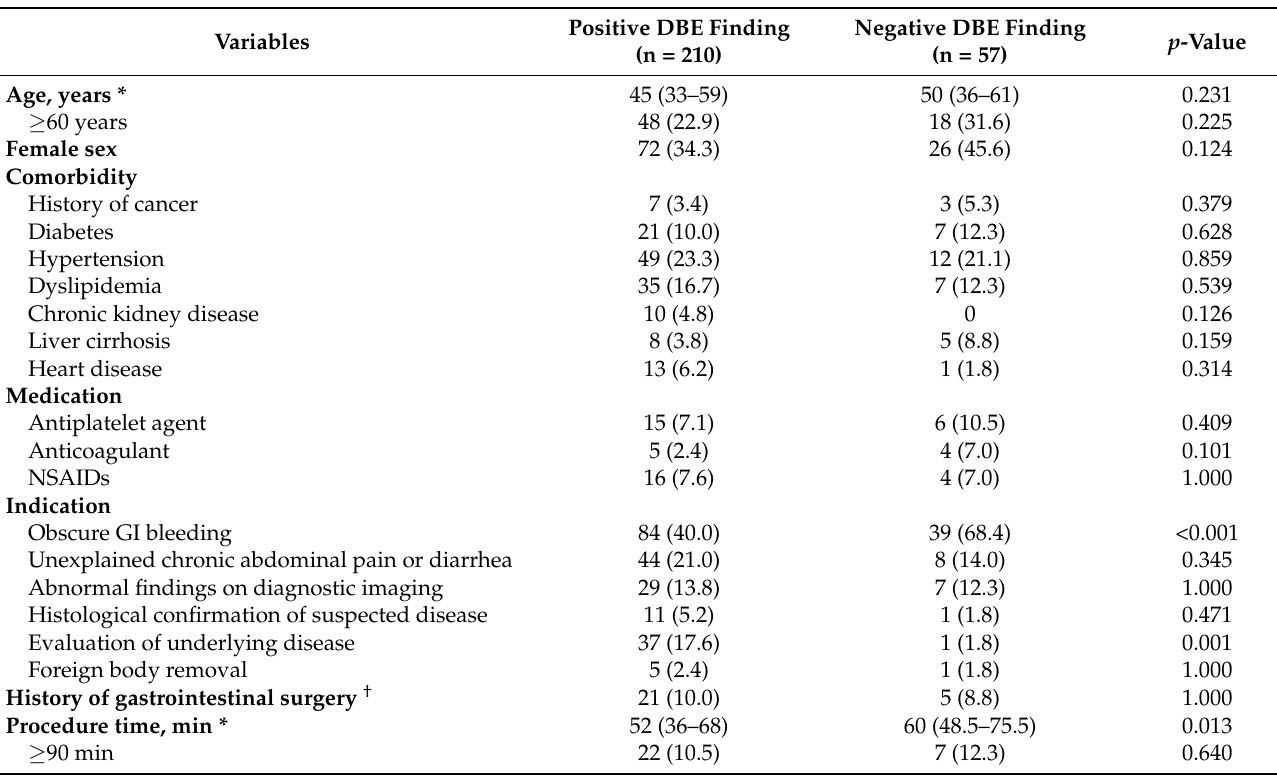
Table 3. Comparison between patients with positive DBE finding and those with negative DBE